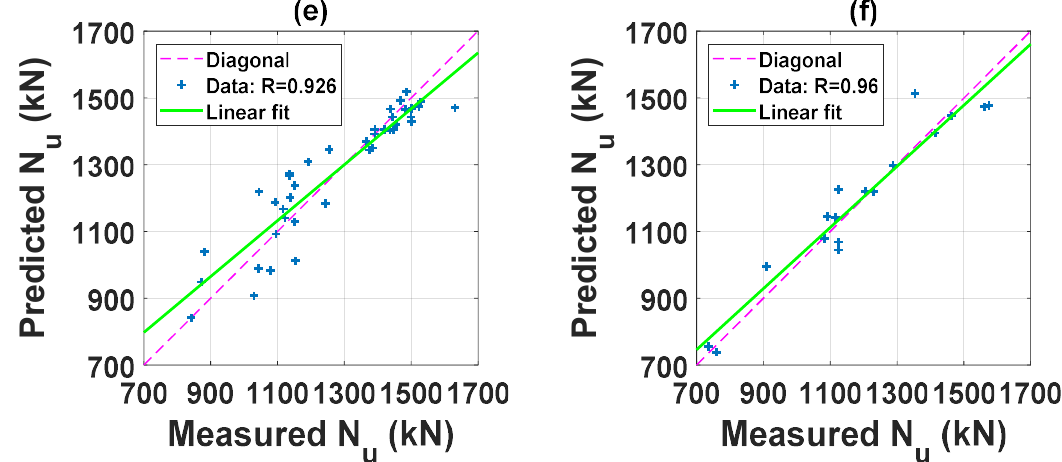
Figure 5. Graphs of regression results between measured Nu versus predicted Nu for the training part using ( a ) ANFIS, ( c ) ANFIS-SA, and ( e ) ANFIS-BBO; for the testing part using ( b ) ANFIS, ( d ) ANFIS-SA, and ( f ) ANFIS-BBO. Table 3. Summary of prediction